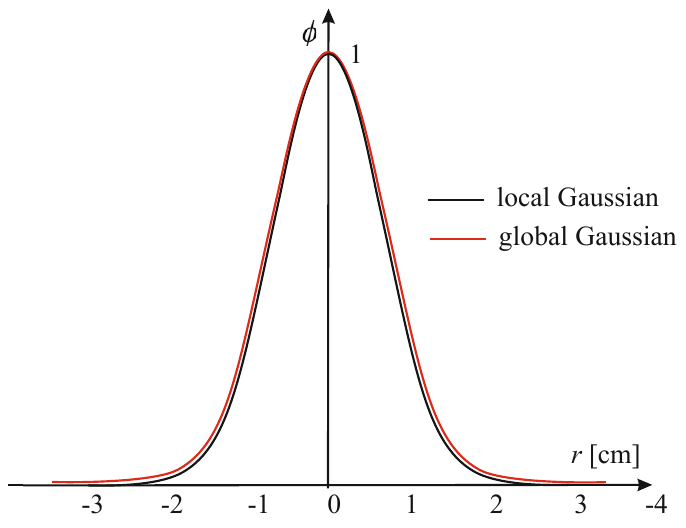
Figure 1. Shapes of global and compactly supported Gaussian RBFs. Radial basis functions can be used to process scattered data from GPR. Two types of approaches are used for this purpose: RBF interpolation or approximation.